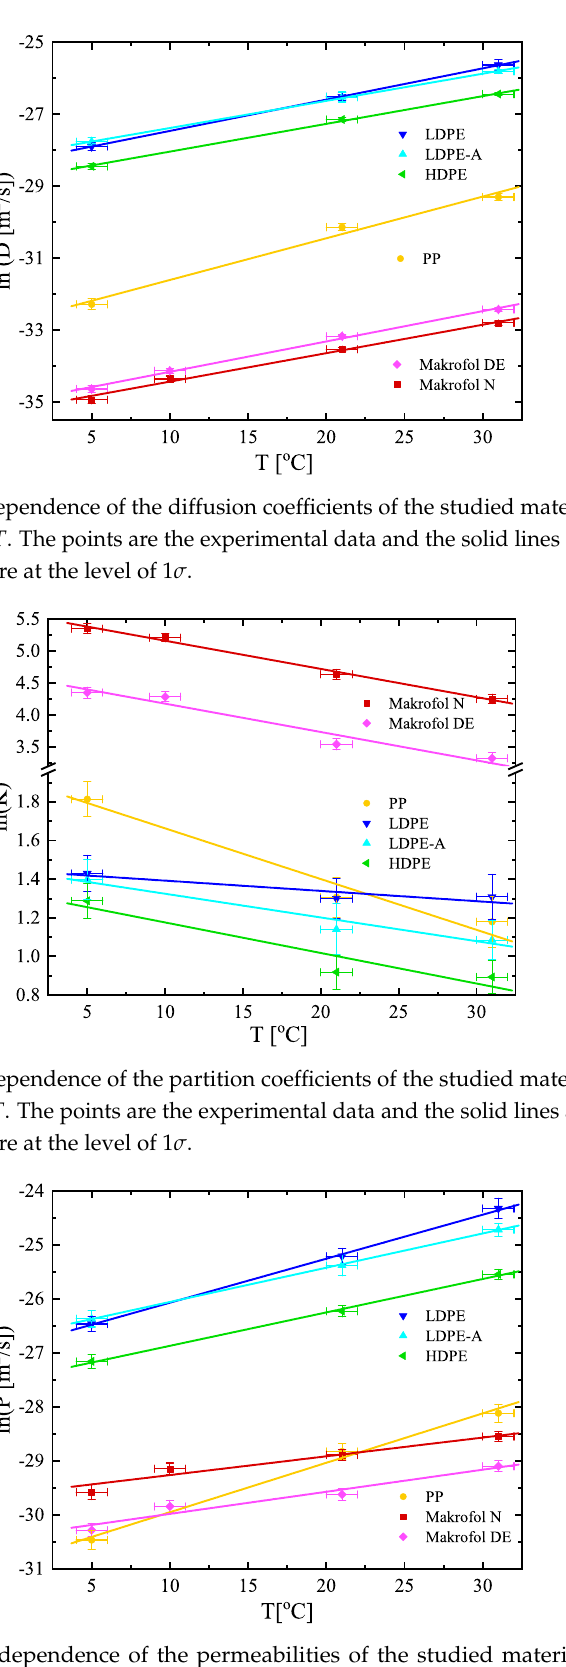
Figure 7. Temperature dependence of the permeabilities of the studied materials. Note that the dependence is ln( P ) vs. T . The points are the experimental data and the solid lines are linear fits of the data. The uncertainties are at the level of 1 σ